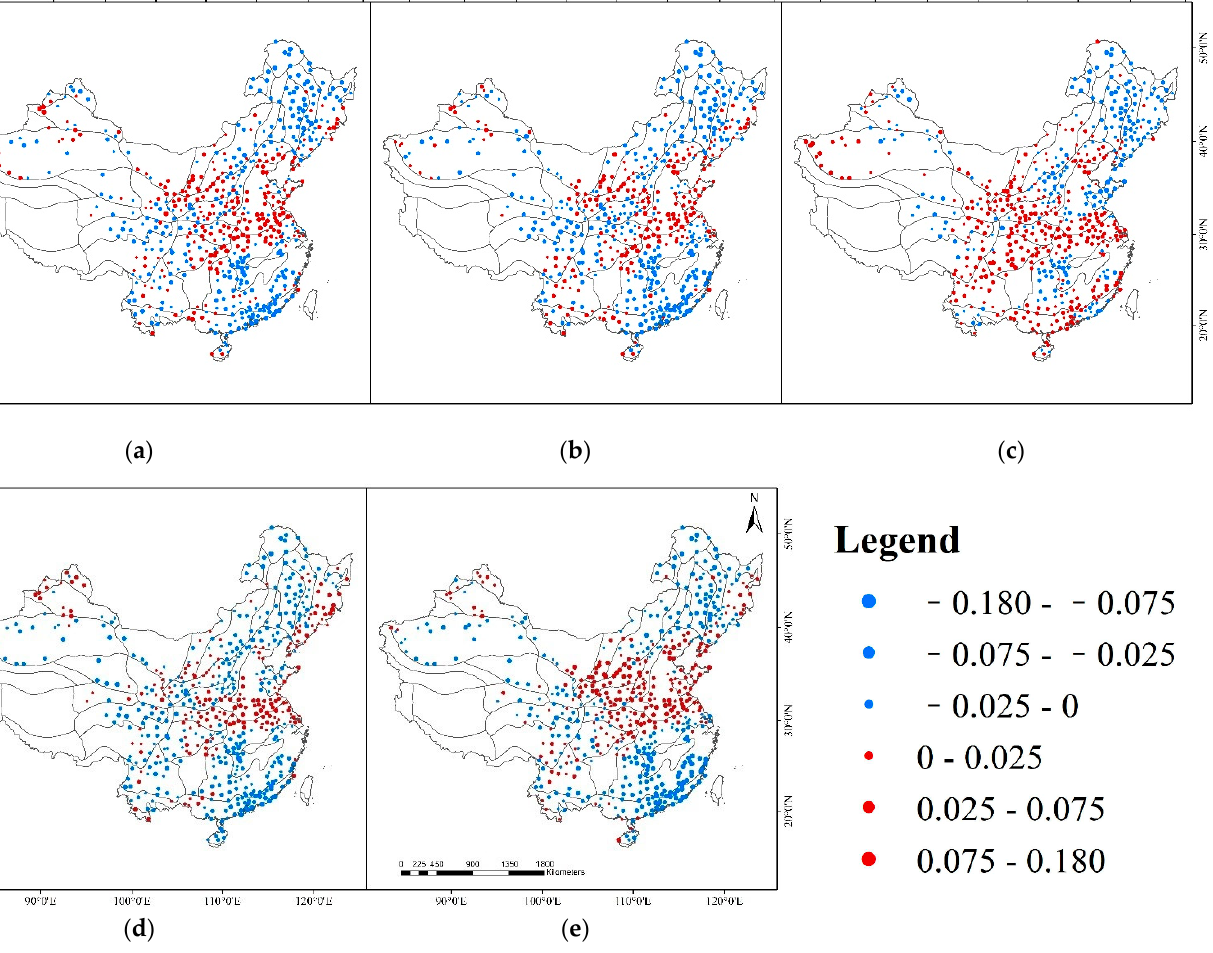
Figure 6. Correlation between the meteorological drought indices and RMM (except the South China Sea Islands): ( a – e ) spatial distribution of the correlation coefficient between PDSI, SC_PDSI, SPEI- 1, SPEI- 6, SPEI- 12 and RMM.